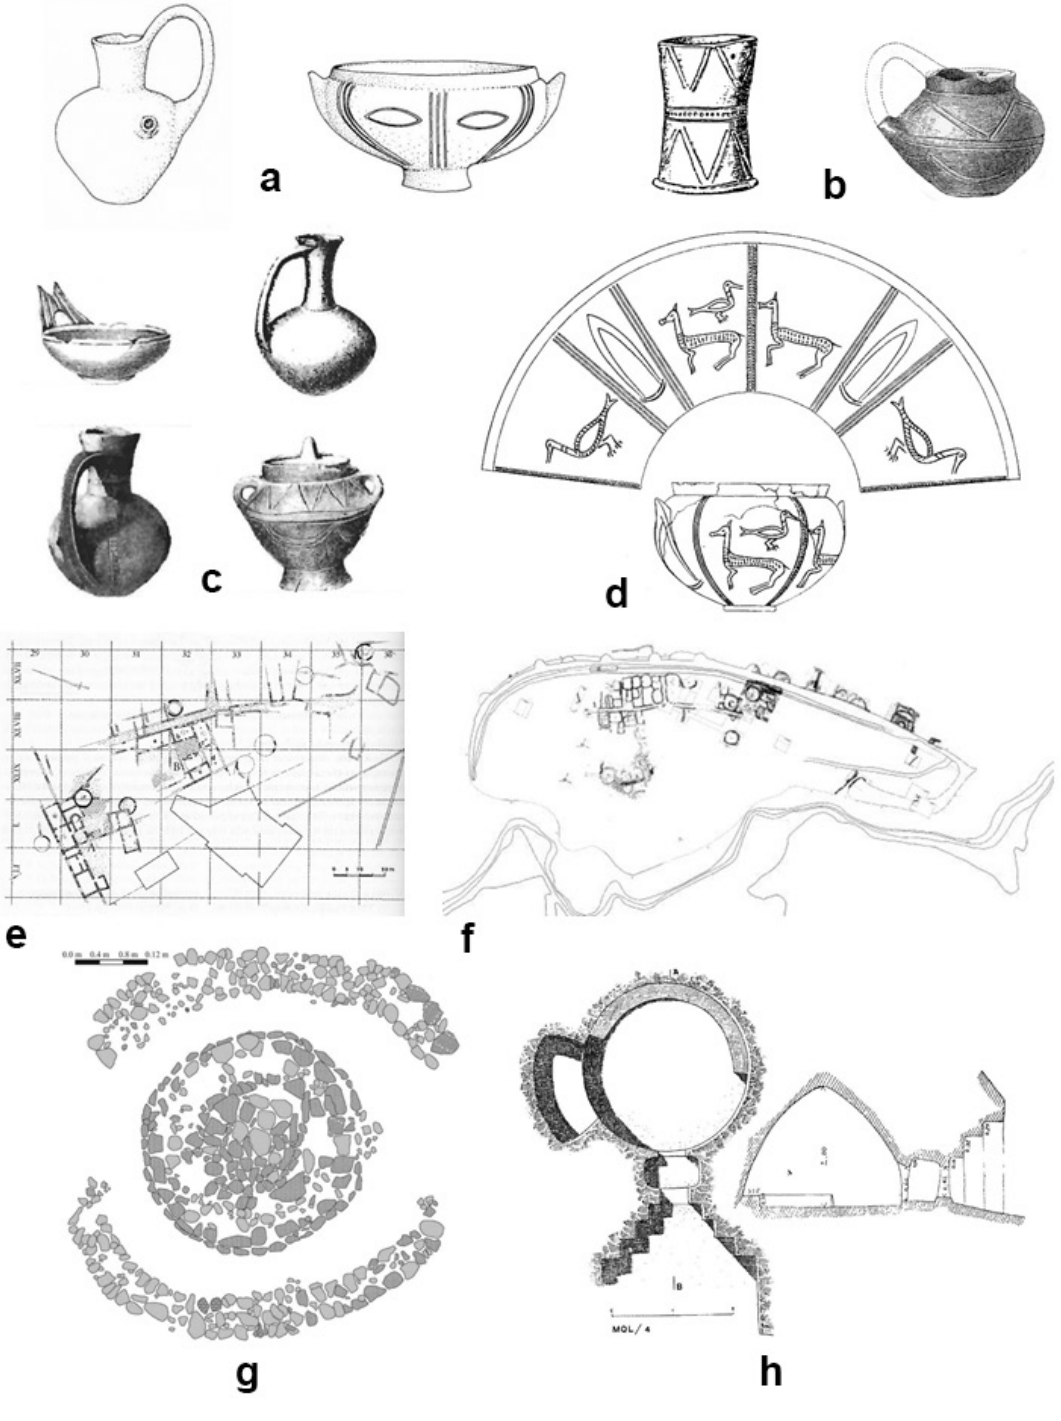
Figure 4: a) Thapsos type spouted jug and bowl of Aegean origin (D’Agata, 2000); b) Thapsos type pyxis and squat bowl of Aegean origin (Alberti, 2004); c) Thapsos pottery shapes imitating Cypriote prototypes (Alberti, 2005); d) Local imitation of Mycenaean Pictorial Style on Thapsos pottery (Vagnetti, 2000–2001); e) Plan of Thapsos settlement (Tomasello, 2004); f) Plan of Faraglioni di Ustica settelement (Spatafora, 2016); g) Plan of the tholos tomb complex at Gazzi di Messina (Bonfiglio et al., 2019); h) Tholos tomb no. 4 from Cozzo Monaco on the Molinello river (Tomasello,